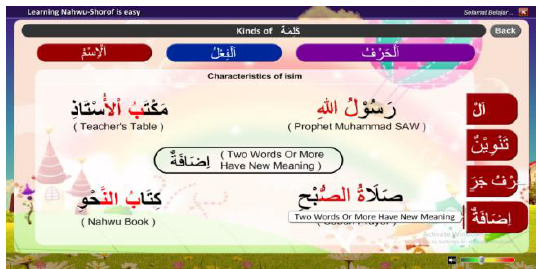
Figure 3. Arabic writing after